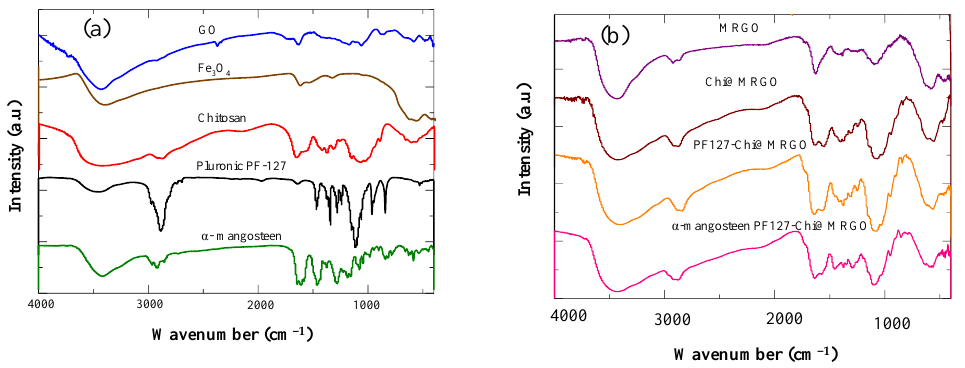
Figure 5. FTIR spectra of GO, Fe 3 O 4 , Chitosan, PF127, and α -mangosteen ( a ); FTIR spectra of MRGO, Chi@MRGO, PF127- Chi@MRGO, and α -mangosteen-loaded PF127-Chi@MRGO nanocom- posites ( b ).